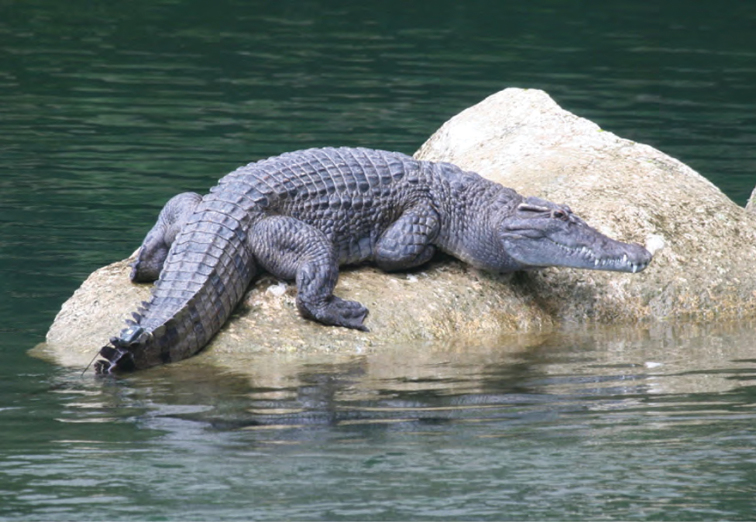
Crocodylus mindorensis basking on a rock in the Disulap River, Barangay Disulap (Location 29): Photo MVW.